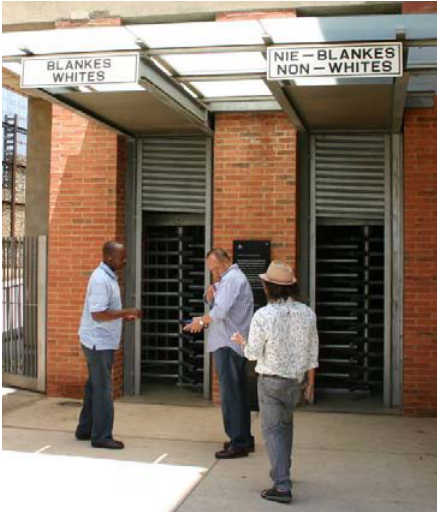
Figure 12. ‘White’ and ‘Non-White’ entrances to the Apartheid Museum, Johannesburg (author’s